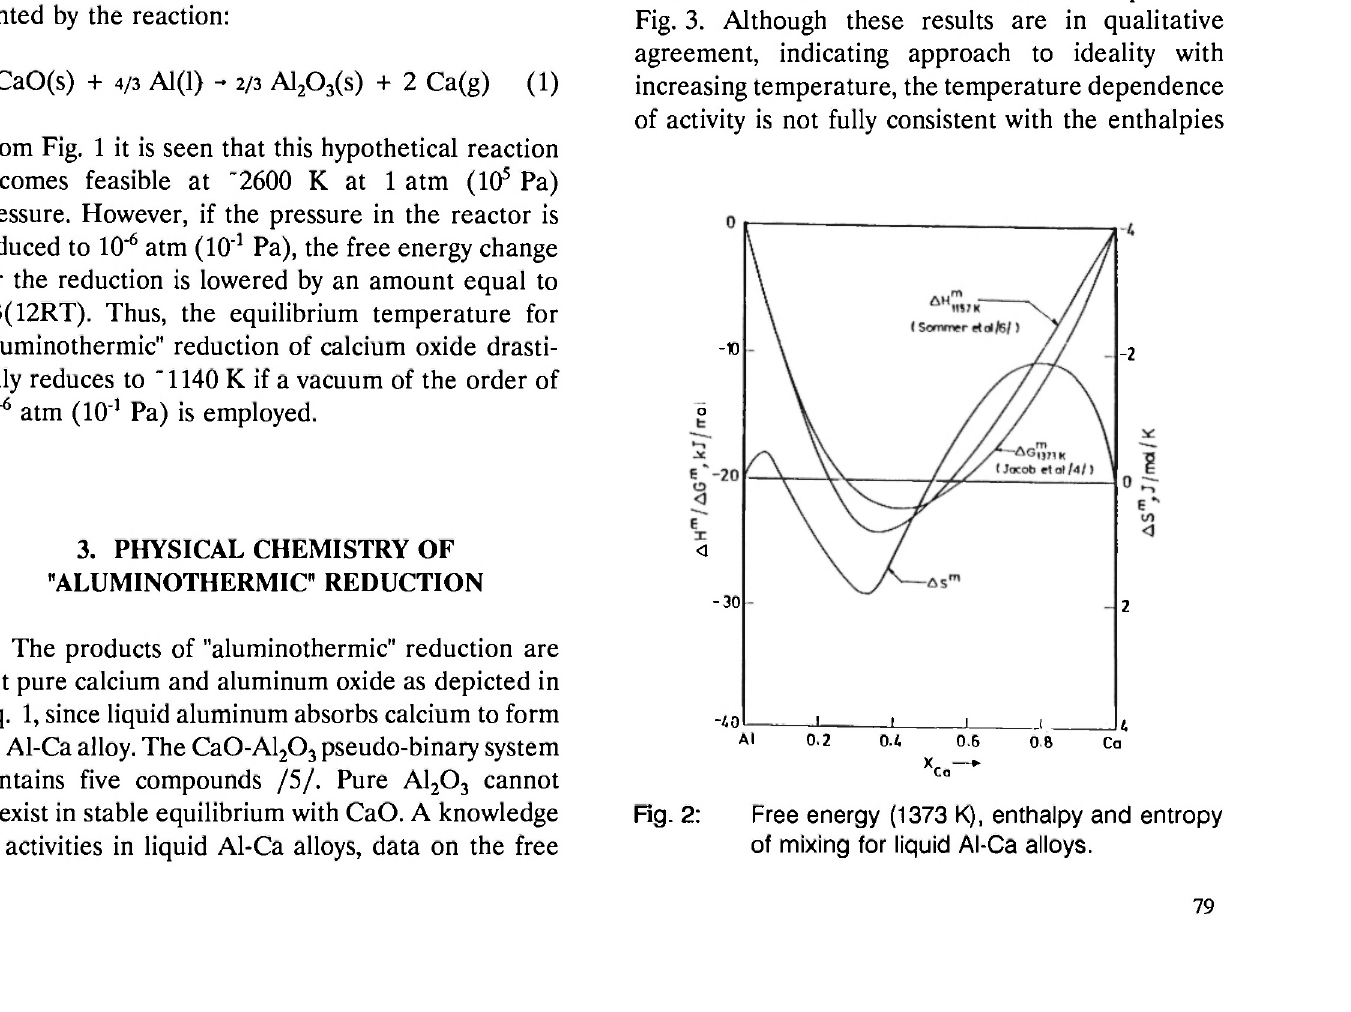
Ellingham diagram for oxides of Ca, Al and C.